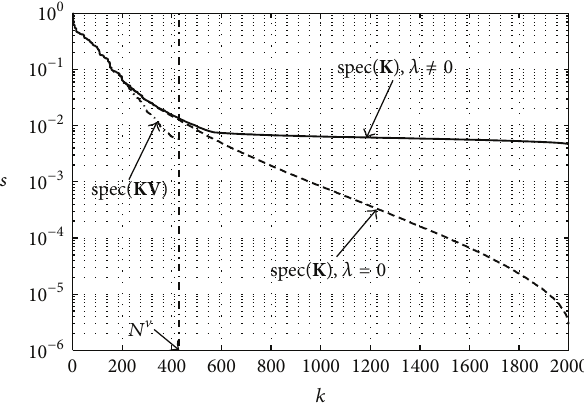
Figure 2: The singular value spectra of the matrix K without regularization ( 𝜆 = 0 ) and with regularization ( 𝜆 ̸= 0 ) for a generic inverse scattering problem with 2000 permittivity unknowns. The spectrum of the matrix KV where V contains the truncated 3D discrete cosine basis corresponding to 𝑁 V = 432